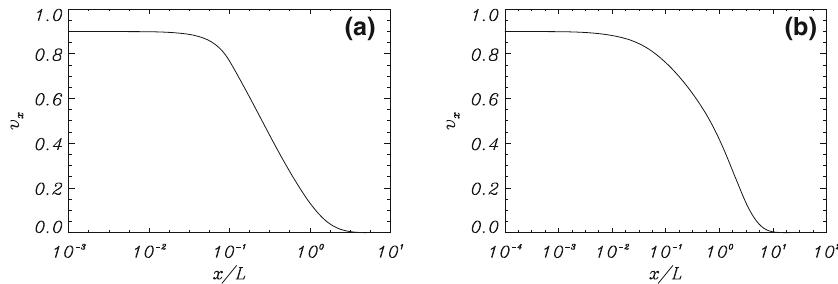
Fig.51 KinkmodenormalvelocitycomponentacrosstheaxisoftheCartesianprominencethreaddepicted in Fig. 50. Solutions are symmetric about the thread axis ( x = 0) and so they are only shown for x ≥ 0. The length of magnetic field lines is 2 L = 200 , 000 km. a In a very thick thread (with a “radius” of 10,000 km) the perturbation is essentially confined to the thread itself, i.e., to 0 ≤ x / L ≤ 0 . 1. b In an actual thread (with a “radius” of 100 km) the velocity displays a large amplitude beyond the thread boundary, at x / L = 0 . 001.Thismeansthatwaveenergyspreadsintothesurroundingcoronalmedium.Imagereproduced with permission from Díaz et al. (2001), copyright by ESO